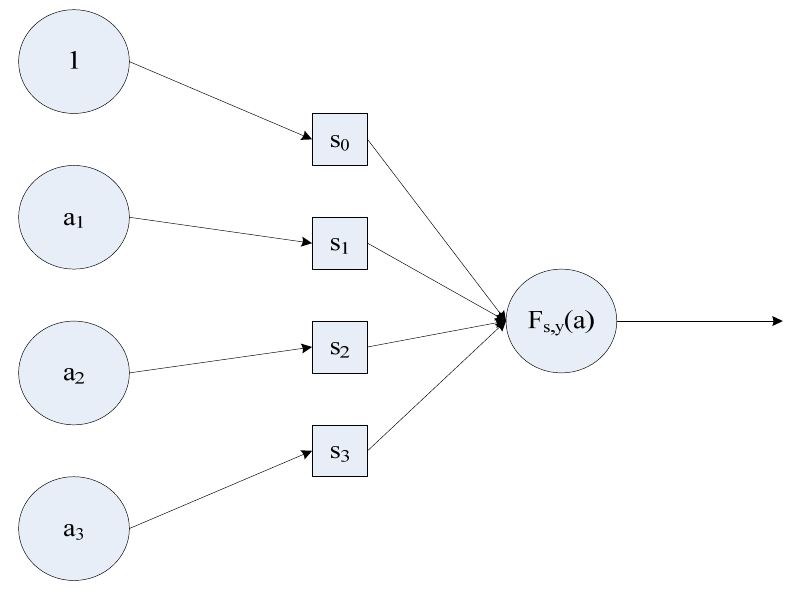
Figure 4. Neuron model.